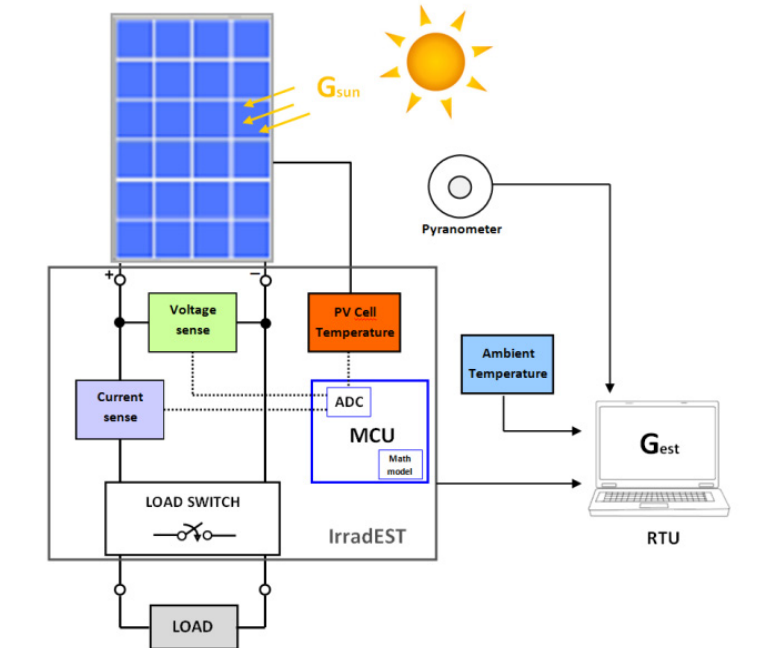
Figure 2. Block diagram of the measuring